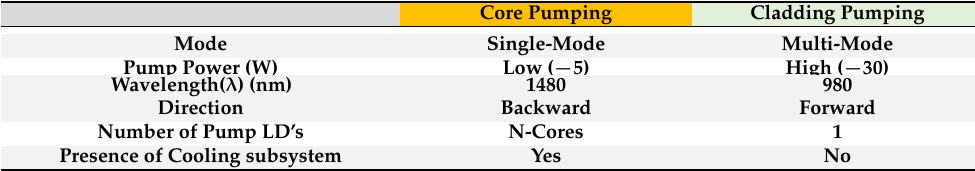
Table 7. Cladding and Core-Pumping